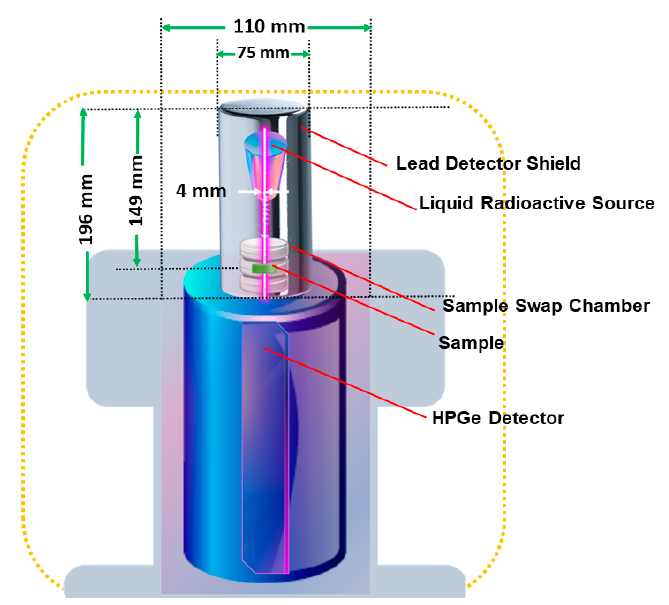
Scheme 2. Diagram of the HPGe detector for gamma irradiation attenuation experiments. Table 2. Calculation equations of radiation shielding factors for the advanced nanocomposites. Radiation Shielding Factors Units Equations